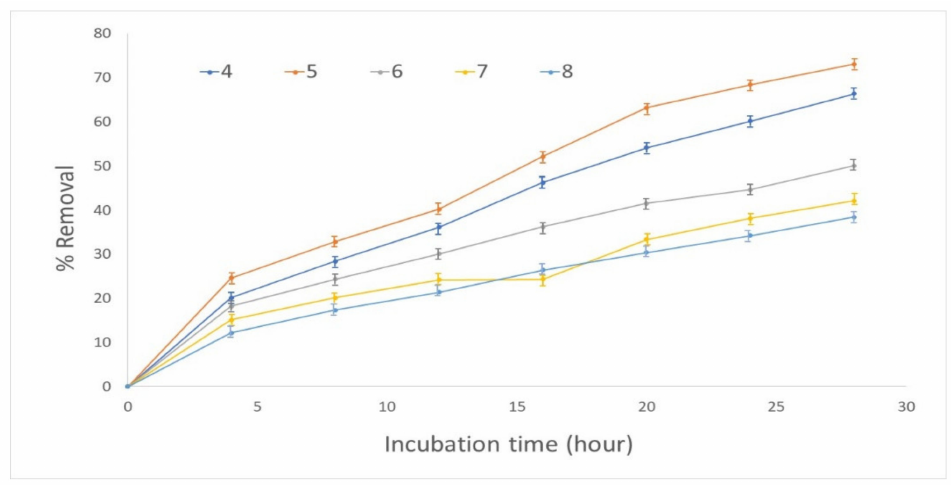
Figure 2. Effect of pH and incubation time on the removal of cobalt (II) by E. crassipes . 100 mg/L cobalt (II). 28 ◦ C. 100 rpm. 1 g of natural biomass.